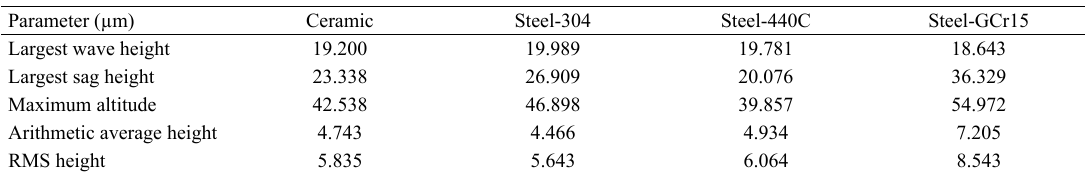
Figure 10. The deepest point and sectional view of the grinding marks on the 9Cr18Mo sample surface for different frictional Table 2. The worn surface parameters for the 9Cr18Mo sample in function of the secondary frictional pair.